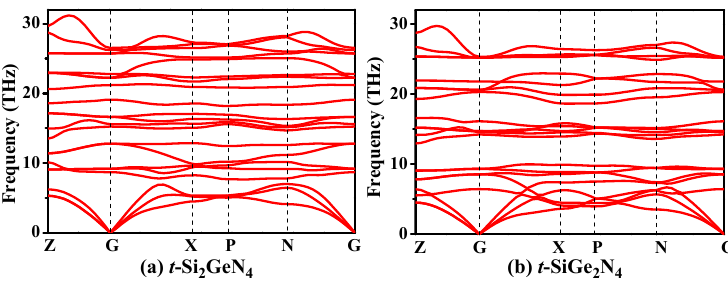
Figure 3. Phonon spectra for t -Si 2 GeN 4 ( a ) and t -SiGe 2 N 4 ( b ).